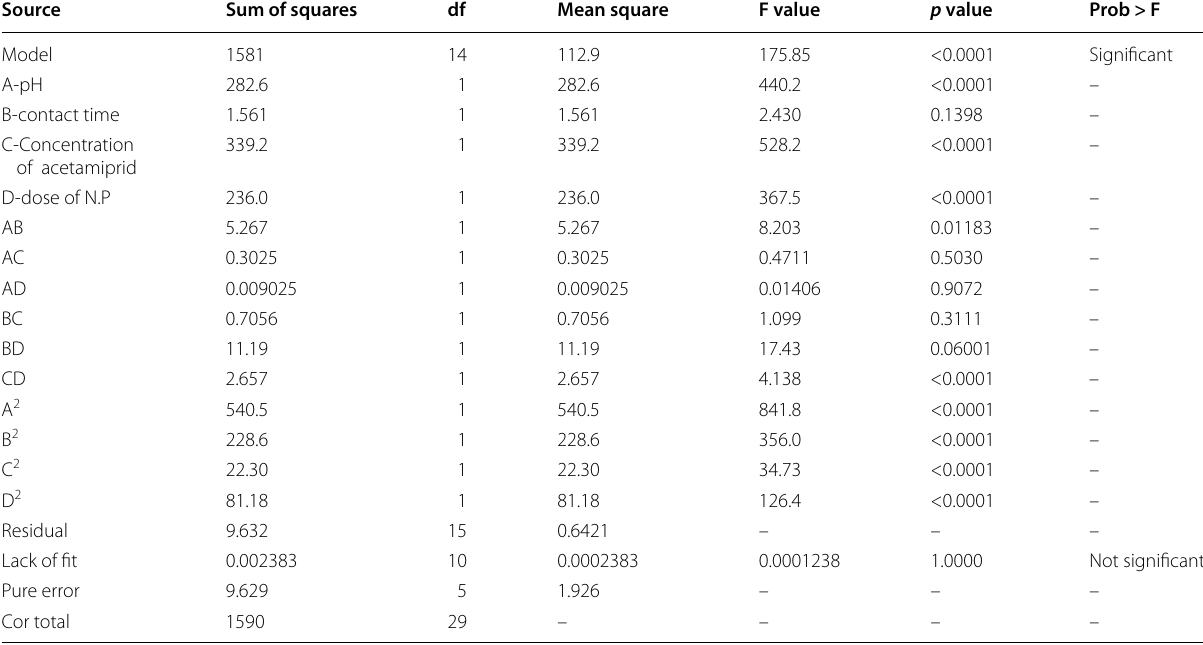
Table 4 ANOVA for response surface quadratic model: analysis of variance table (partial sum of squares—Type III)